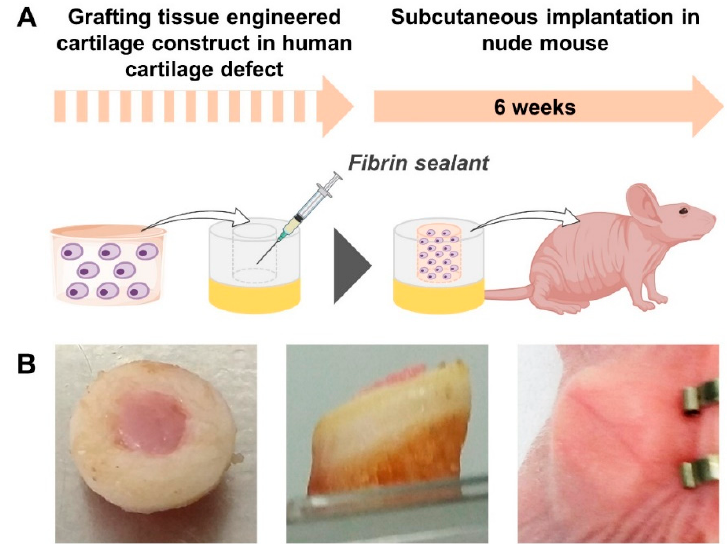
Figure 6. Scheme of the in vivo study. ( A ): Following extraction and monolayer expansion, HACs were seeded in fibrin hydrogel and cultured for 3 weeks in a direct perfusion bioreactor. Cartilage constructs were then fixed in fresh human osteochondral blocks with fibrin sealant and hybrid constructs were implanted into the subcutaneous pockets of nude mice for 6 weeks. The stability of the neo-synthesized matrix was assessed by histology. ( B ): Macroscopic pictures showing (left to right) the cartilage gel fixed in the human osteochondral block from top and side views as well as the hybrid construct implanted under mouse skin.